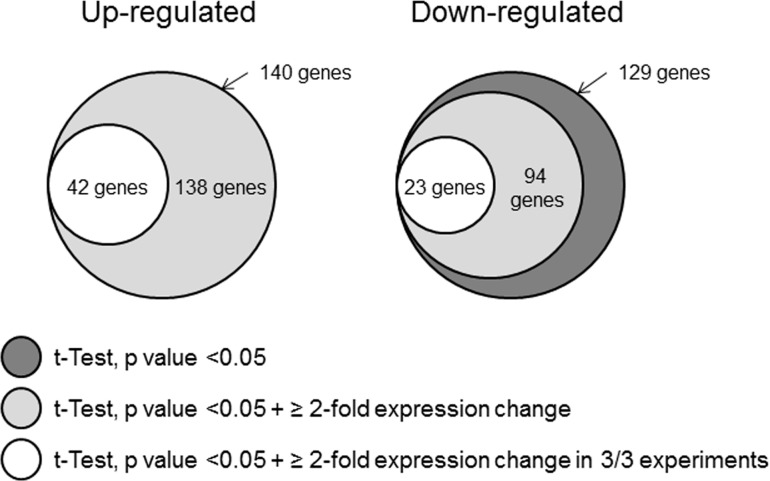
Differentially expressed pneumococcal genes identified by the application of data filtering algorithms.Gene lists generated by GeneSpring GX software were initially filtered using the students’ t-Test analysis of variance to yield only those genes with a p-value <0.05. Of these genes, only those displaying a mean ≥ 2-fold expression change were selected. Finally, only those genes meeting the filtering criteria in all biological replicates (n = 3) for a particular experimental condition were selected.